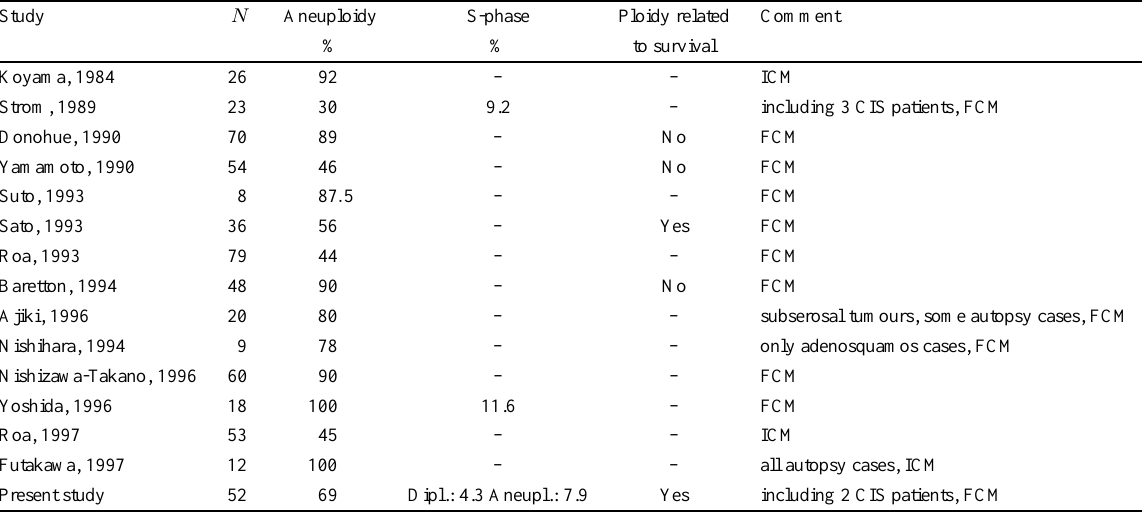
Data of 15 studies of DNA flow cytometry from tumour tissue in gallbladder cancer